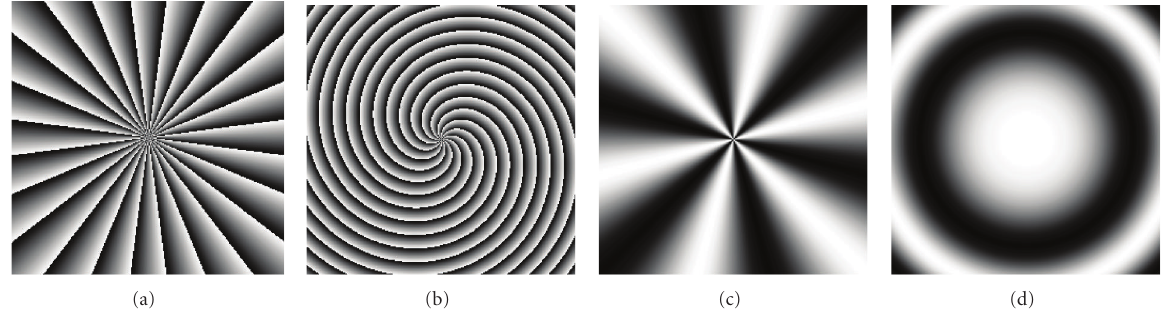
Figure 13: The phase distributions of (a) reference wave φ r 1 = mθ and (b) reference wave φ r 2 = mθ + Cr . (c) Test wave with azimuthal phase variation. (d) Test wave with radial phase variation.